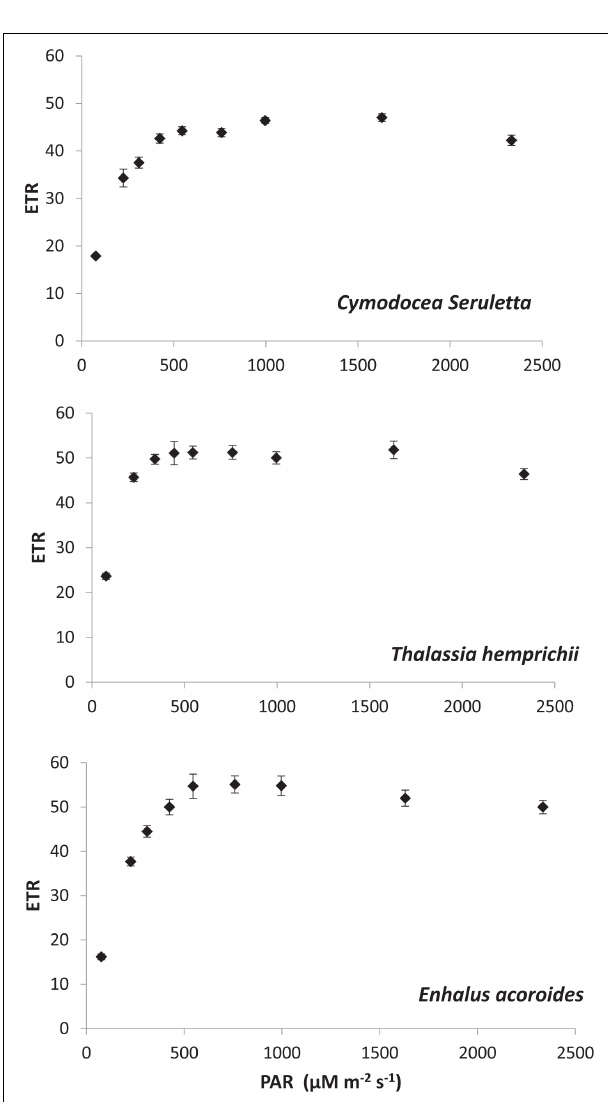
followed by T. hemprichii and C. serrulata ( p < 0.001). The minimum saturating irradiance (I k ) was highest in E. acoroides . However, the light limited photosynthetic efficiency ( α ) was the highest for T. hemprichii, followed by C. serrulata and E. acoroides ( p < 0.001). Under ambient water quality conditions, the highest down regulation of the photosynthetic process, under